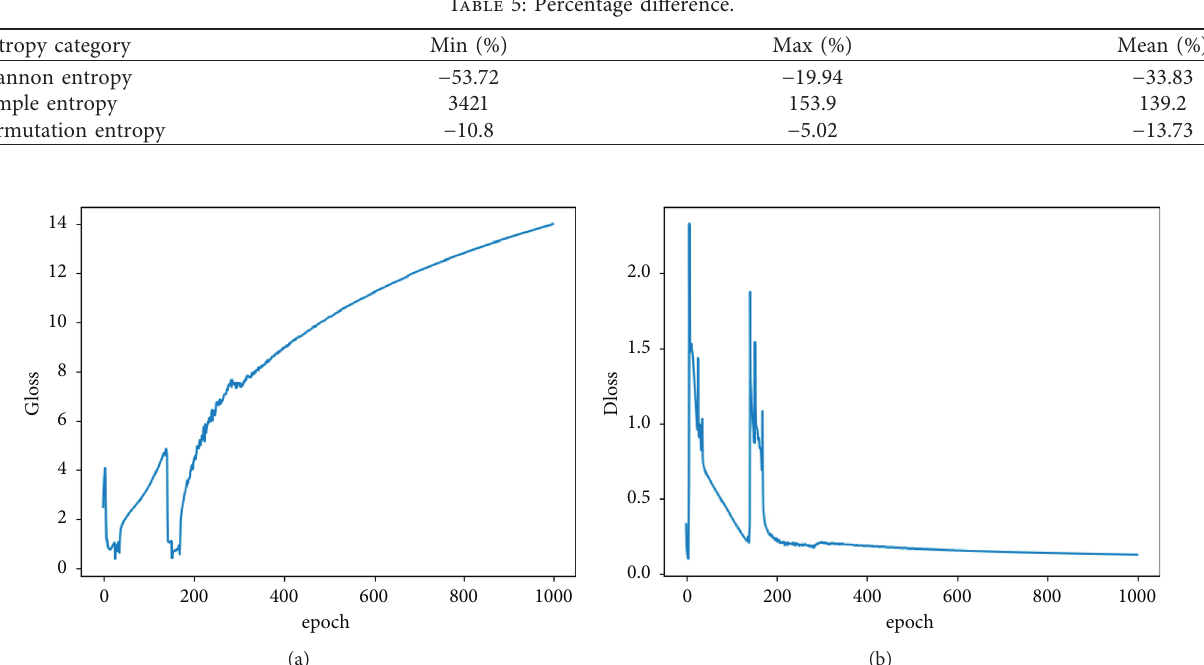
Figure 8: Variation curves of generator loss and discriminator loss